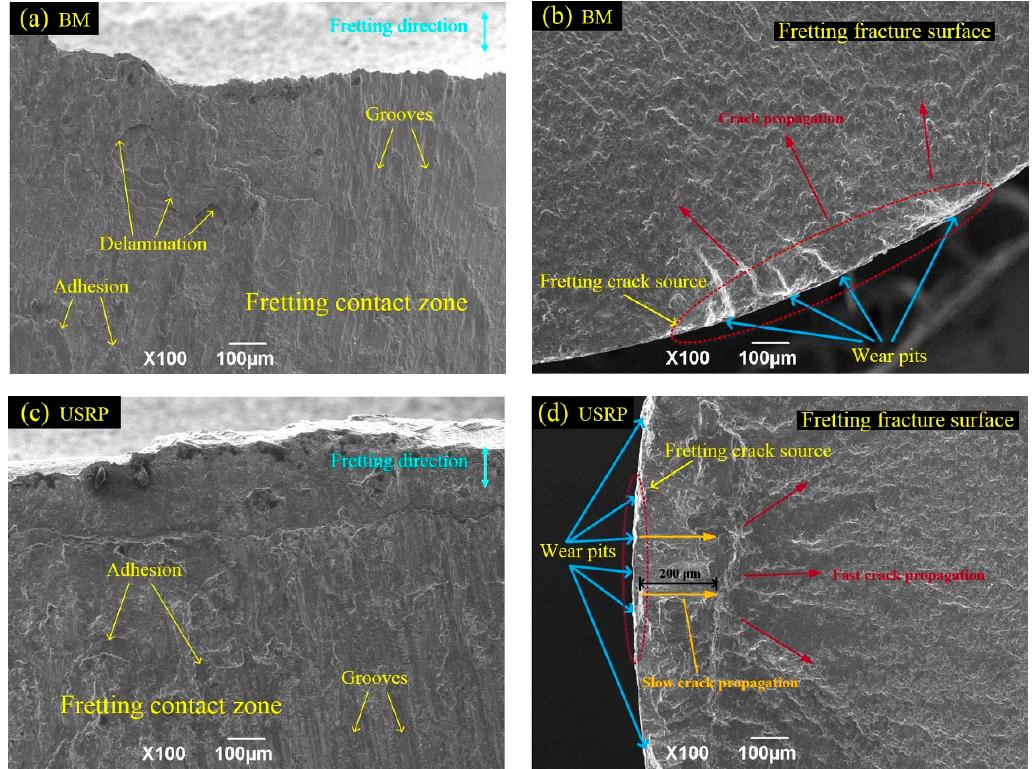
Figure 10. Morphologies of the fretting contact zones and the fracture surfaces of BM and USRP samples: ( a , b ) BM sample; ( c , d ) USRP sample (maximum stress level σ max = 500 MPa).